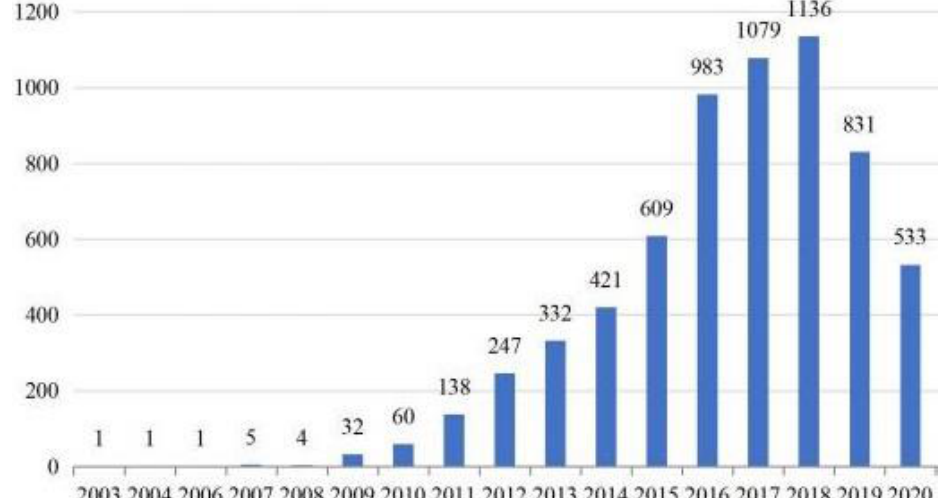
Figure 6. The total amount of patent application for supercapacitors in China since 2003.